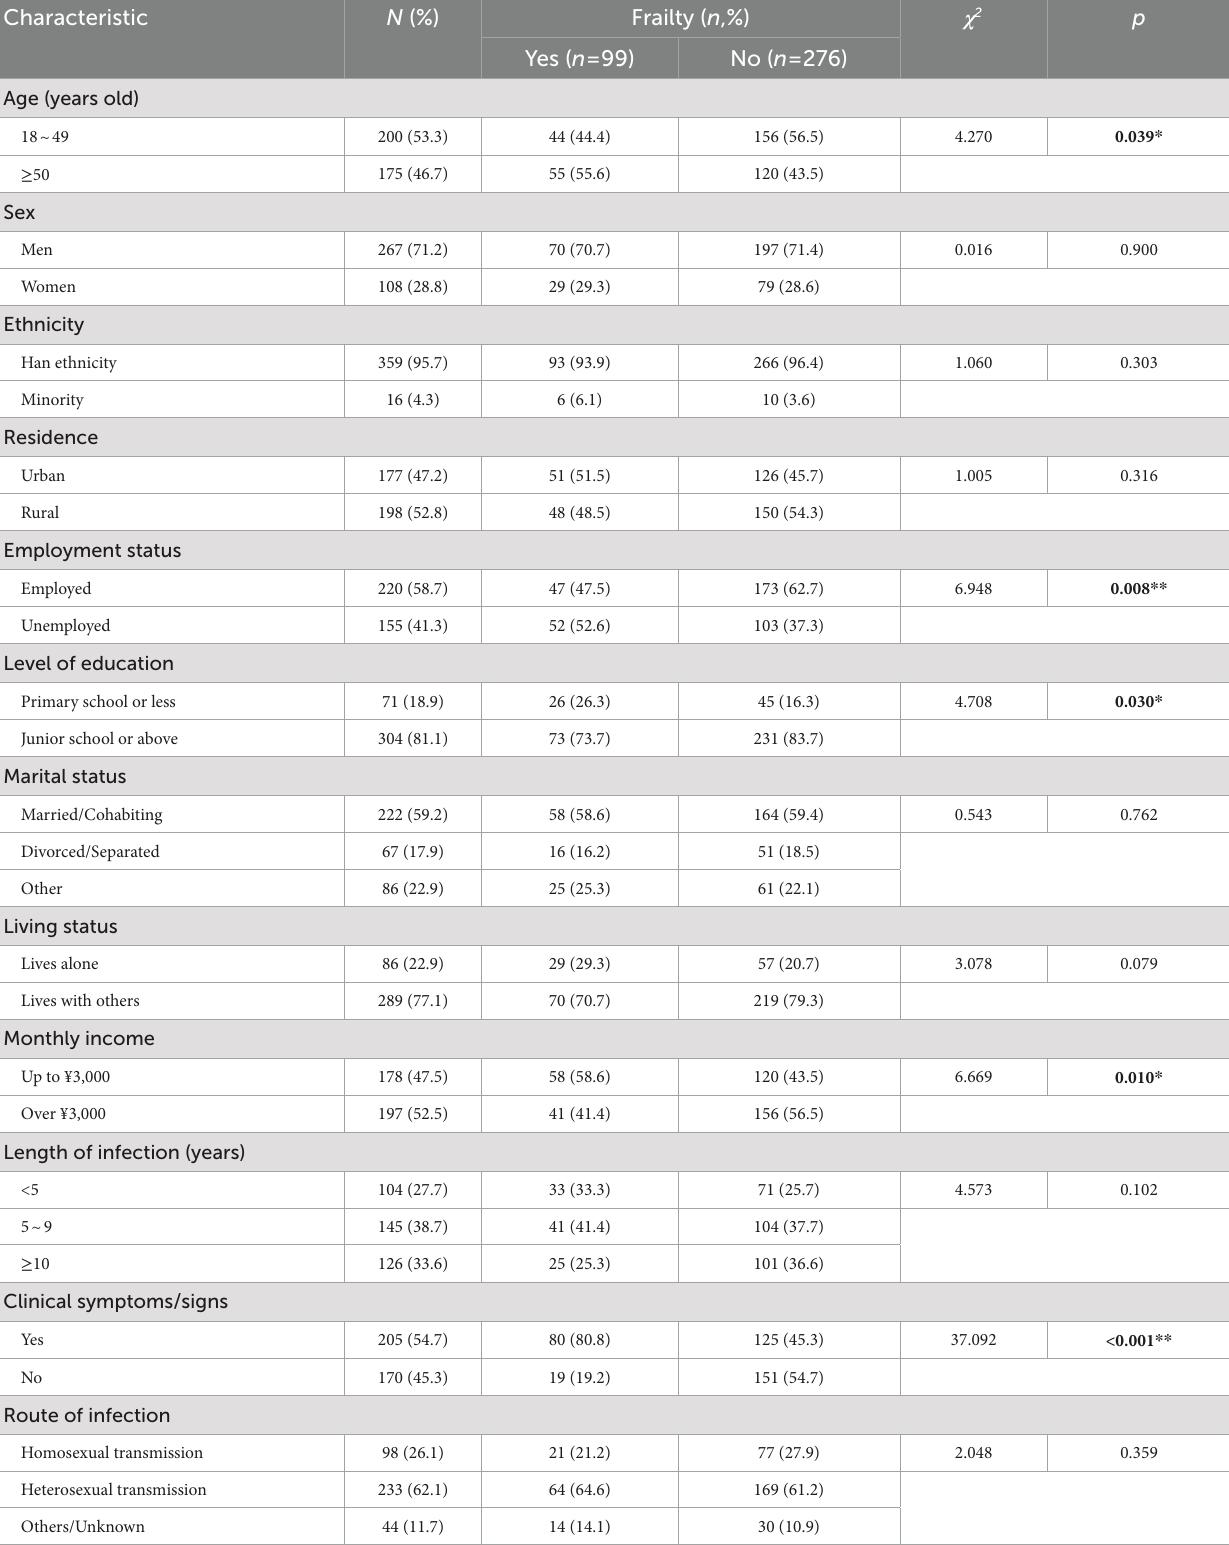
TABLE 1 Different demographic characteristics and the distribution of frailty ( n = 375). Characteristic N (%) Frailty ( n